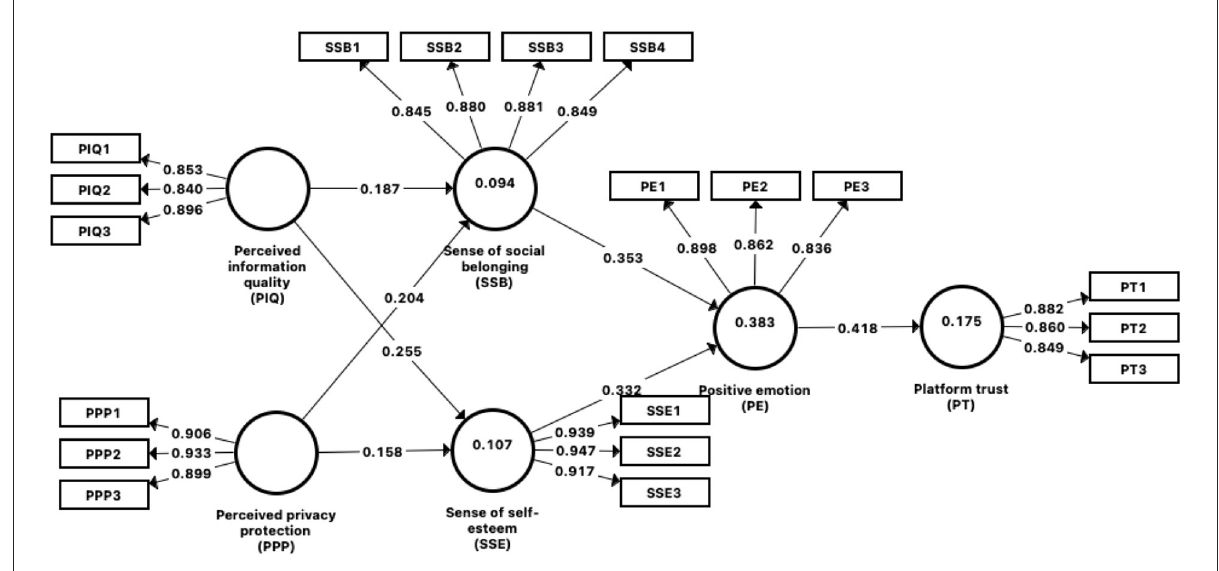
FIGURE2 Structural model results.